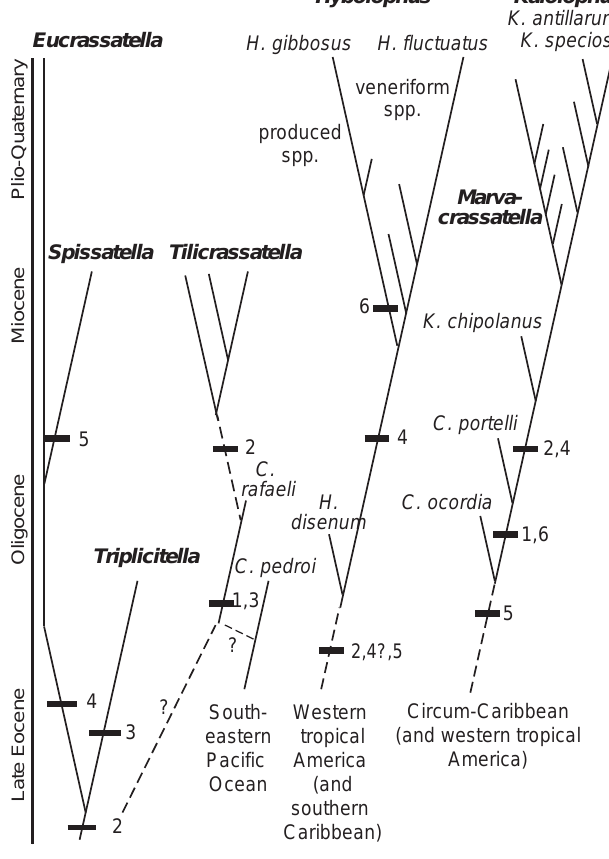
Fig. 11. Proposed intuitive evolutionary trees for crassatellines descended from Paleogene Crassatella species in the southern Pacific Ocean and cir- cum-Caribbean. Derived characters marked with horizontal bars and keyed by number to list of characters: 1, occasional presence of large resilifer; 2, always presence of large resilifer; 3, occasional loss of ventral marginal crenulation; 4, always loss of ventral marginal crenulation; 5, occasional extension of left cardinal tooth to beak; 6, always extension of left cardinal tooth to beak. Dashed lines with question marks represent alternative hy- potheses regarding origin of Crassatella rafaeli in south-central Peru. New Zealand tree modified from Collins et al. (2014).